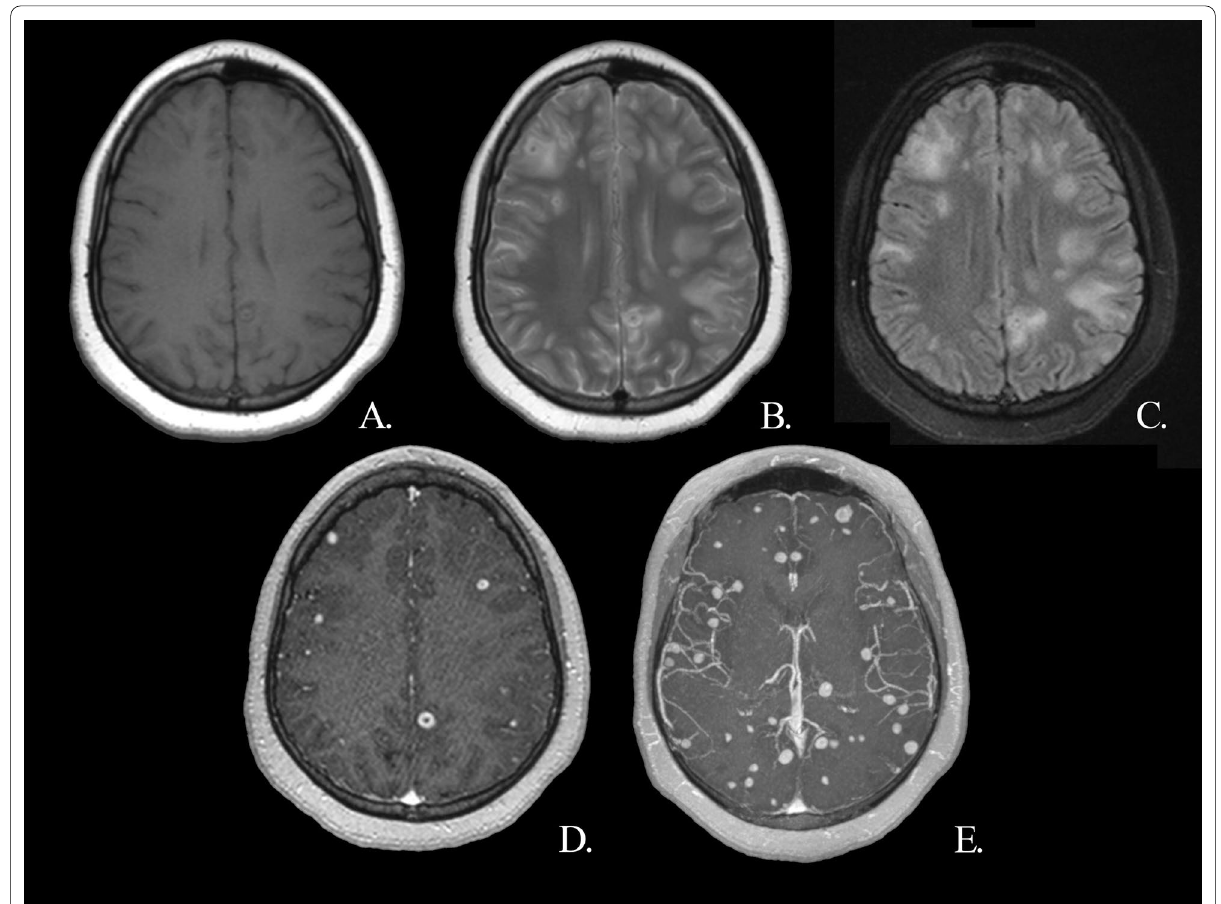
Fig. 1 Patient’s first MRI on admission. Multiple hypointense, nodular lesions ranging in size from 5 to 9 mm were observed on T1W ( A ), T2W ( B ), and FLAIR C images, showing infratentorial and supratentorial distribution with partial preservation of the central parts. The lesions did not show diffusion restriction (not shown) and there was surrounding vasogenic edema, which was observed as a patchy signal increase on T2 and FLAIR images ( B , C ). There was no signal loss in the suscebtibility-weighted images (not shown). In contrast-enhanced images, ring-like enhancement was observed mostly, and homogeneous nodular enhancement was observed in a few smaller lesions ( D ). Note the high number and watershed localization of the lesions on post-contrast T1W axial MIP images ( E ). FLAIR fluid-attenuated inversion recovery, MIP maximum intensity projection, T1W T1 weighted, T2W T2